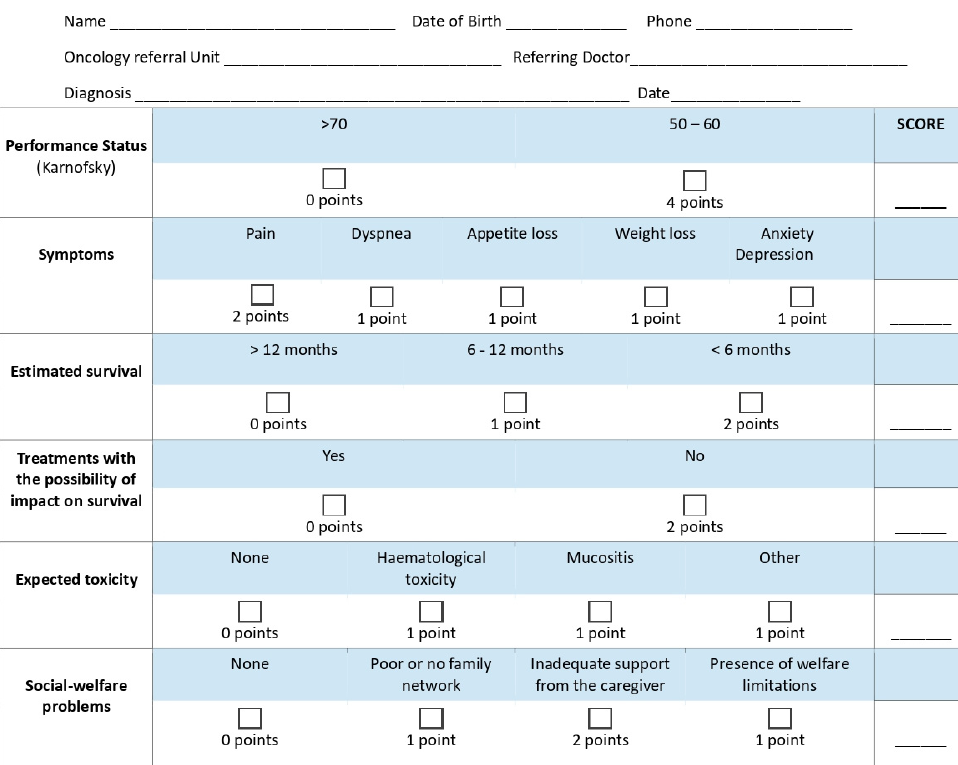
Figure A1. Simultaneous-care referral form.